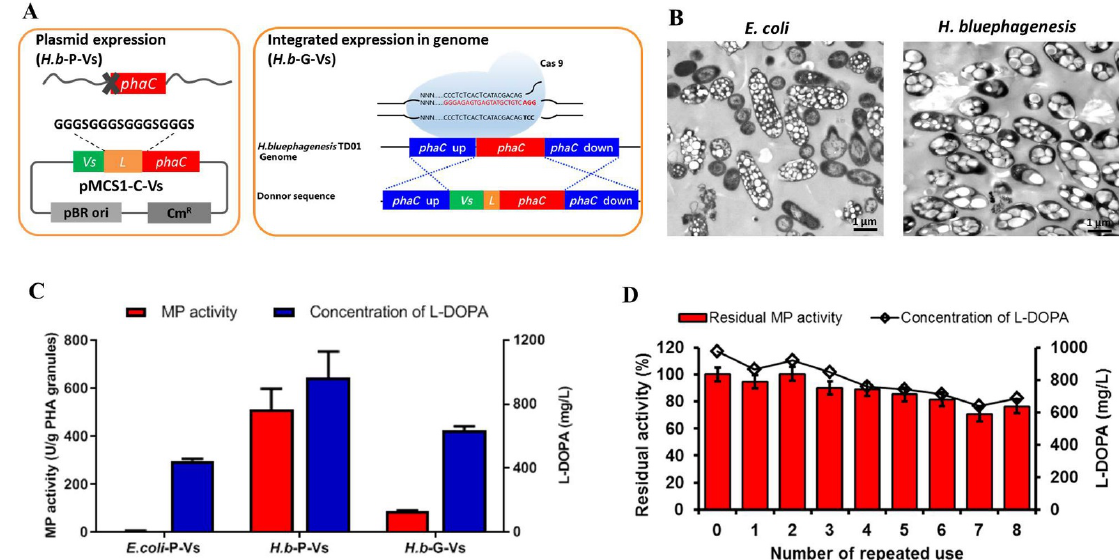
Figure 4. Production and characterization of PHA-TyrVs nanogranules produced by H. bluephagenesis : ( A ) plasmid expression and integrated expression of tyrVs-phaC Hb fusion gene in H. bluephagenesis , to generate two PHA nanogranules producers, H.b -P-Vs and H.b -G-Vs, respectively. The tyrVs gene was fused to the 5 ′ end of phaC Hb gene via a 16-amino-acid linker; ( B ) TEM observation of PHA nanogranules in the cell of E. coli and H. bluephagenesis after cultured for 48 h. Bar: 1 μ m; ( C ) comparison of monophenolase (MP) activity and L-DOPA yield of purified PHA-TyrVs nanogranules produced in three hosts. Moreover, 1 mL enzymatic reaction was performed under the optimized condition of 2.5 mM L-tyrosine, 5 mM ascorbic acid, 1 μ M Cu 2+ , and 1.5 mg/mL PHA-TyrVs nanogranules, pH 6.0 and 50 °C, rotating at 200 rpm for 3 h. ( D ) Reusability of PHA-TyrVs nanogranules produced by H. bluephagenesis H.b -P-Vs that has the highest content of TyrVs immobilized on PHA surface. After one cycle of 3 h reaction for L-DOPA synthesis, the PHA-TyrVs nanogranules were recycled and resuspended in the same reaction mixture and repeated for eight rounds. The initial activity was set to 100%.